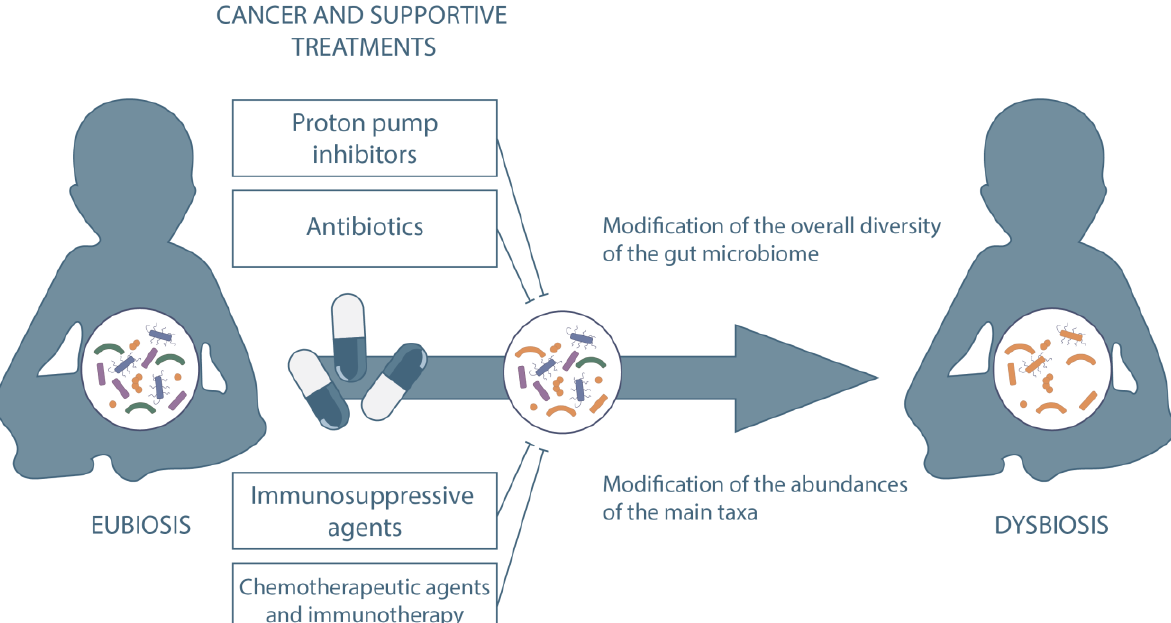
Figure 1. Impact on GM of drugs commonly used in clinical practice in pediatric patients with can- cer.